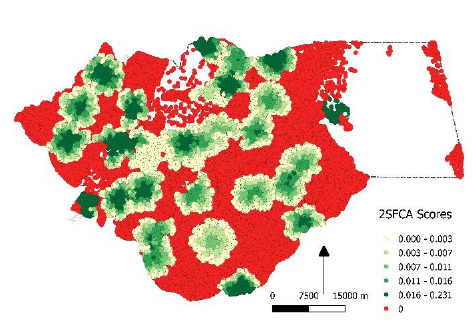
Figure 8 Distribution of accessibility scores for